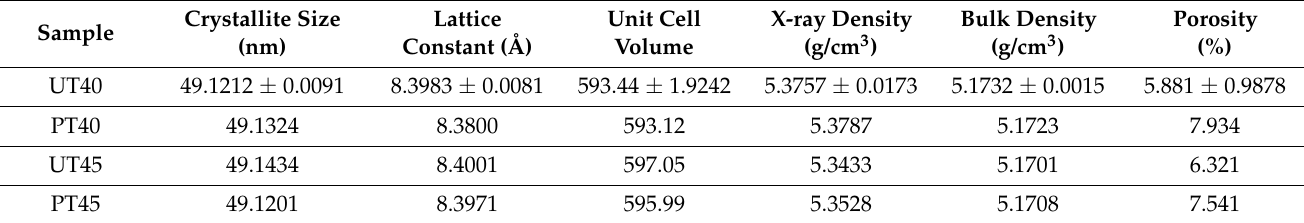
Table 1. The data extracted from XRD spectra of pristine and plasma-processed NiCuZn